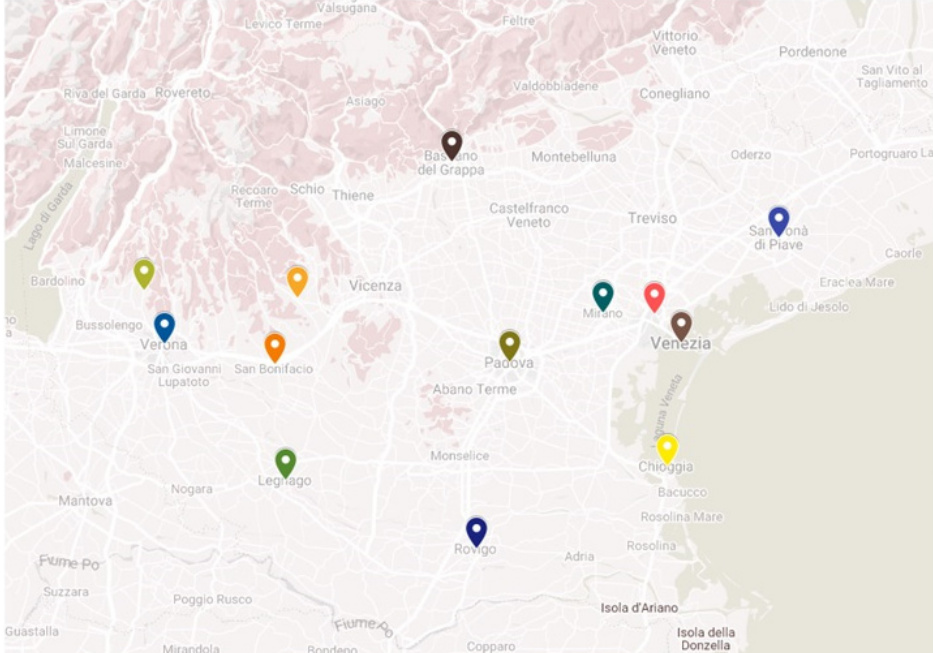
Figure 1. Location of enrolling centers.